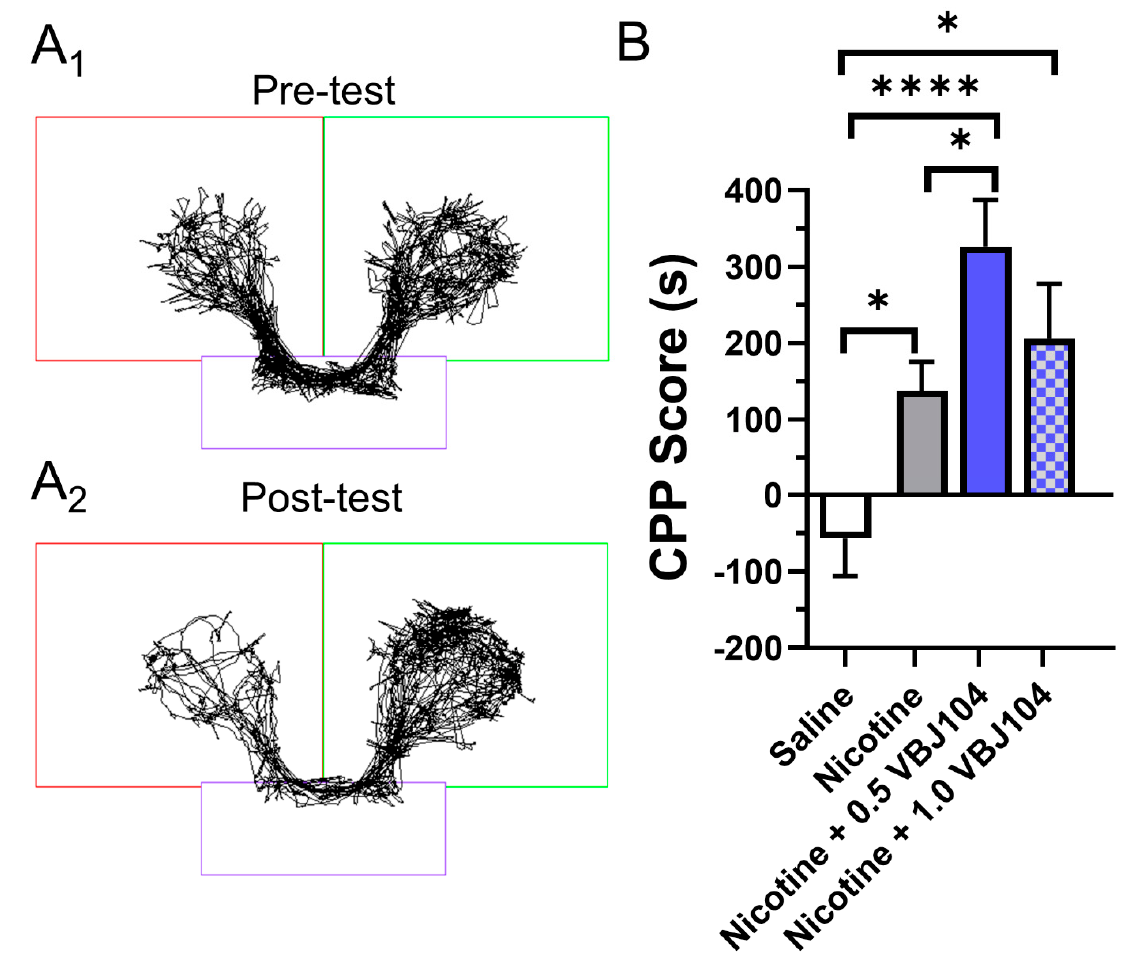
Figure 2. ( A 1 , A 2 ) Representative time-traces for a mouse used in pre- and post-tests in a conditioned place preference assay and assigned to the 0.5 mg/kg nicotine treatment group. ( B ) Male and female mice were assigned saline, 0.5 mg/kg nicotine, 0.5 mg/kg VBJ104 plus 0.5 mg/kg nicotine, or 1.0 mg/kg VBJ104 plus 0.5 mg/kg nicotine, and used in a CPP assay (via intraperitoneal injections; n = 10 mice per condition, 5 males and 5 females). * p < 0.05; **** p <0.0001.